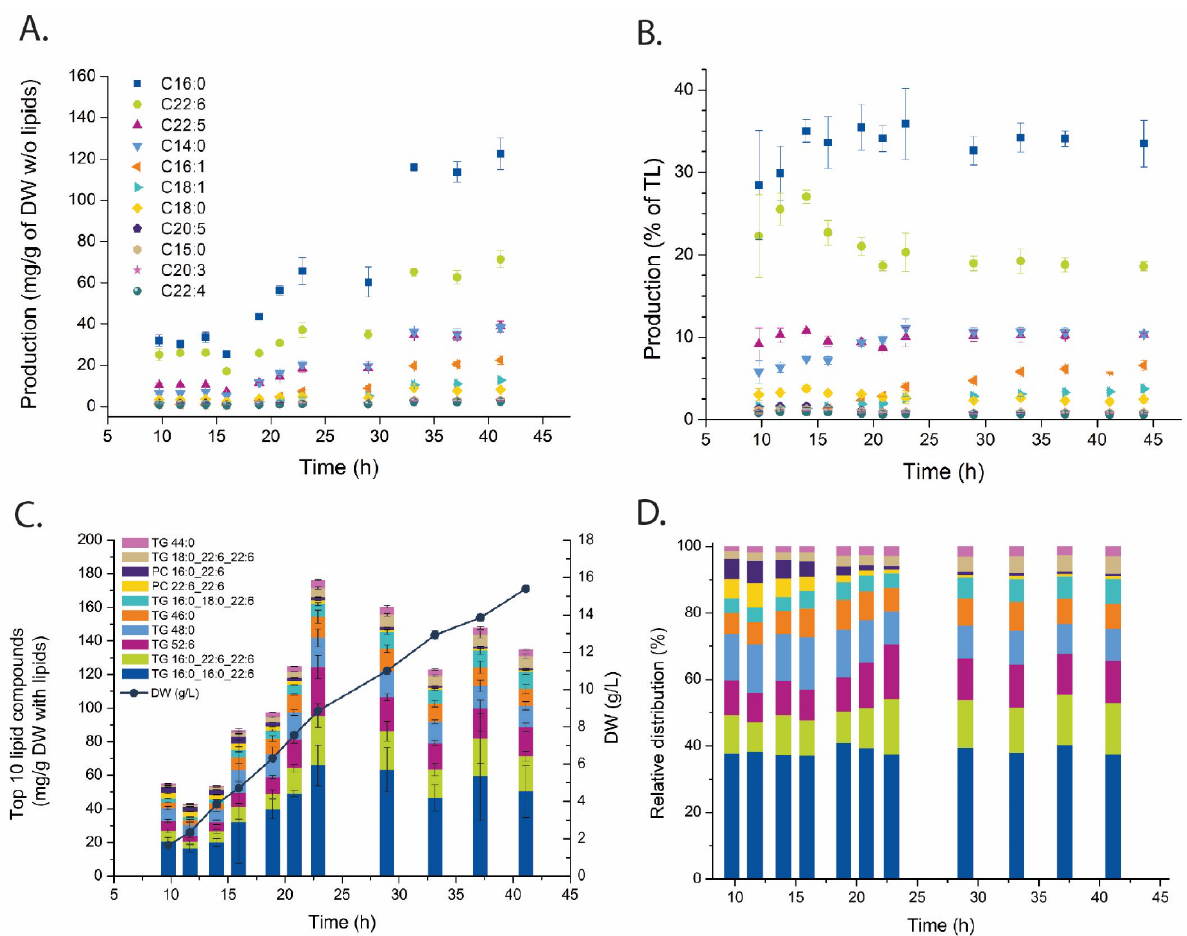
Figure 3. Fatty acid and lipid time series profiling. ( A , B ) Concentration profile and relative distribution of fatty acids, and ( C , D ) the 10 most abundant lipid species. ( A and B ), ( C and D ) share same legends, respectively. TG—triglycerides, PC— phosphatidylcholines. Tabulated data and full identities can be found in Supplementary Tables S2 and S3.